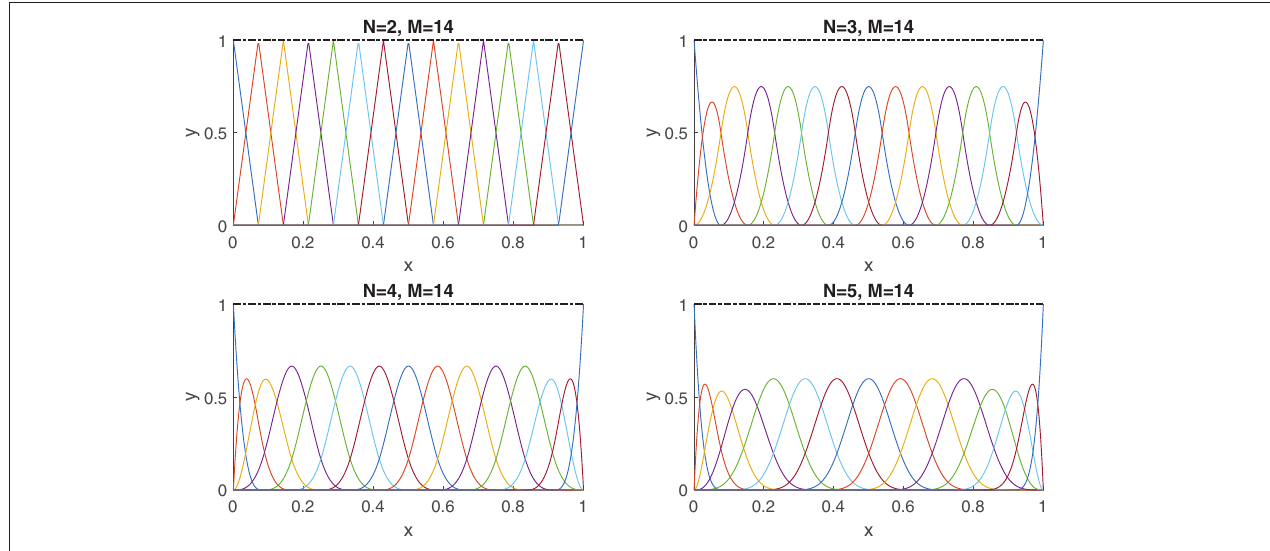
N + M t i i = 0 are = { }